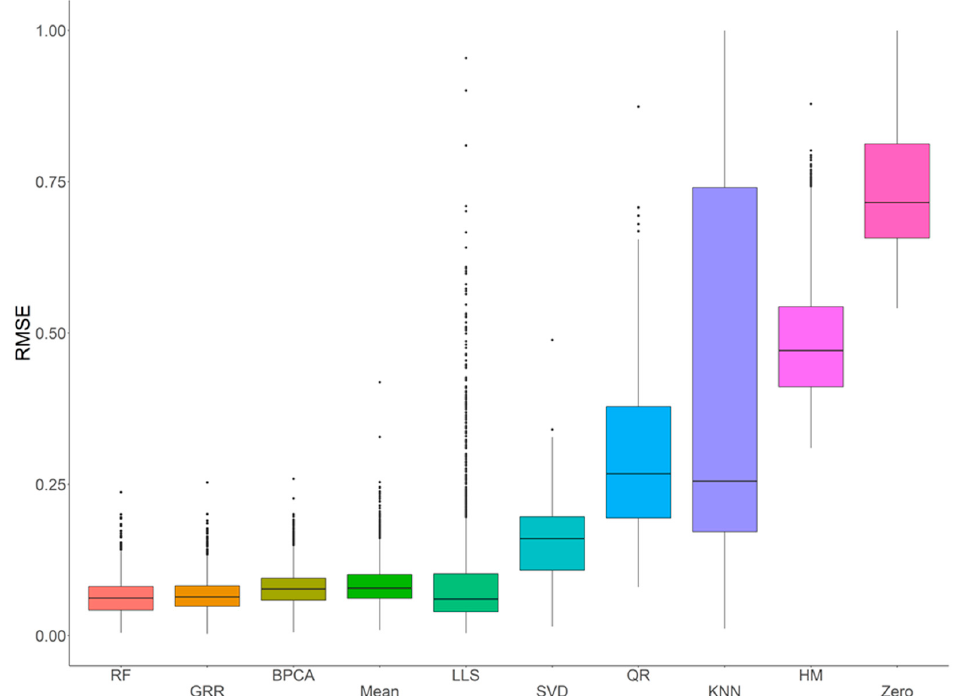
Figure 2. Initial evaluations of imputation accuracy in the complete NIST plasma for a mixture of missingness types (MCAR–MAR–MNAR). Methods are listed across the x-axis, and RMSE is shown on the y-axis. The center line represents the median. The lower and upper box limits represent the 25% and 75% quantiles, respectively. The whiskers extend to the largest observation within the box limit ± 1.5 × interquartile range. Black dots represent single iterations of evaluating RMSE that are outliers. The number of observations for each method is 22,070.